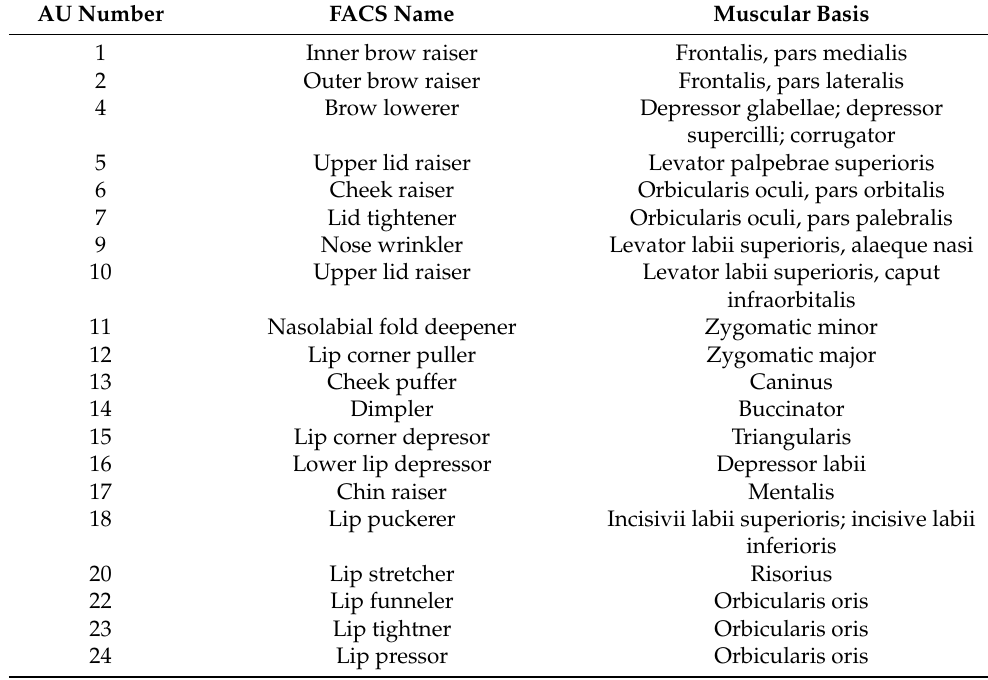
Table A3. Description of the 44 AUs defined by Ekman and Friesen with their name and, when specified, corresponding muscles